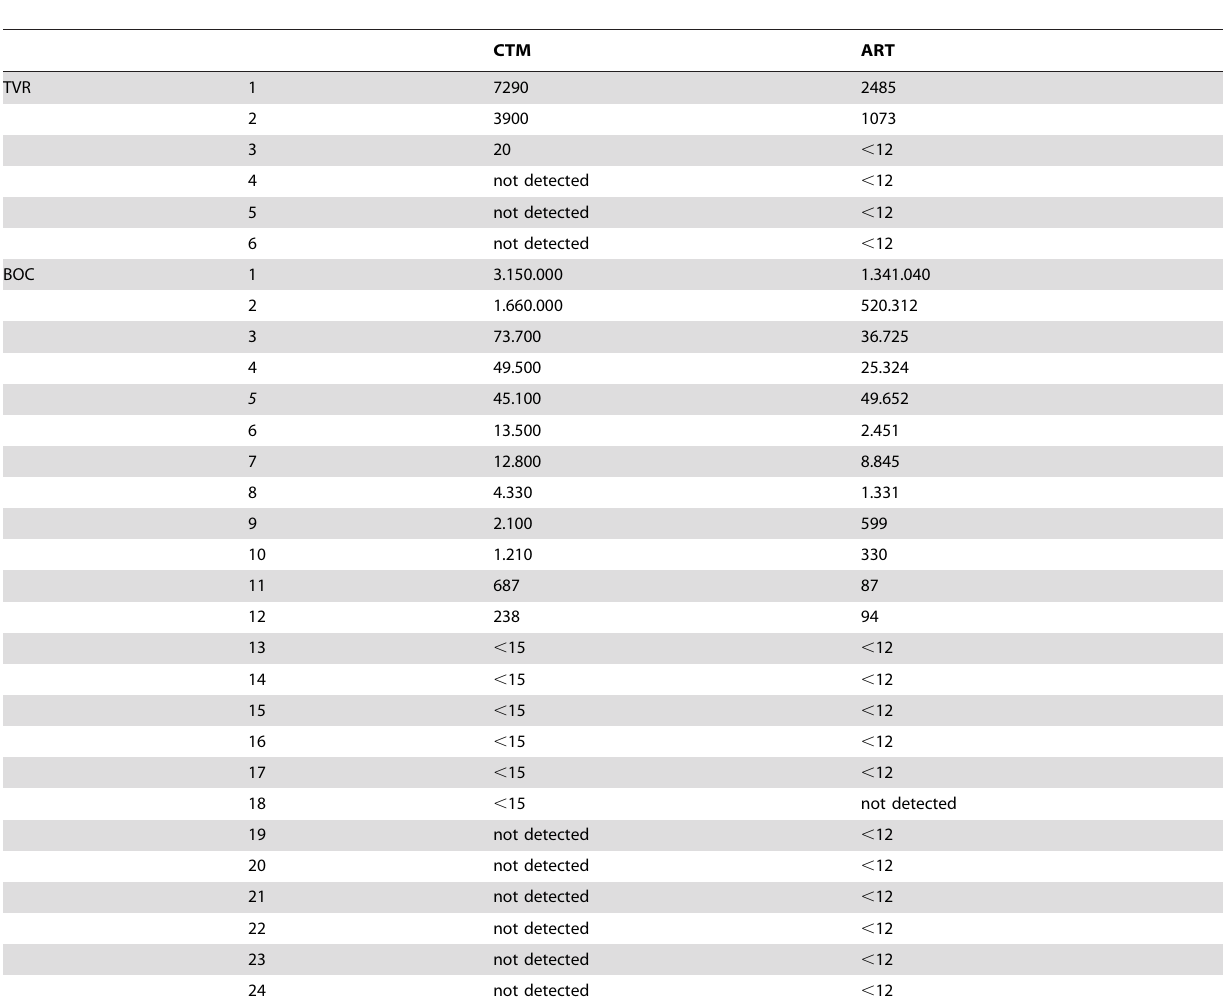
Table 5. Measured HCV RNA level by the ART and CTM in samples obtained 24 weeks after TVR/BOC therapy with a detectable HCV RNA in at least one of the two